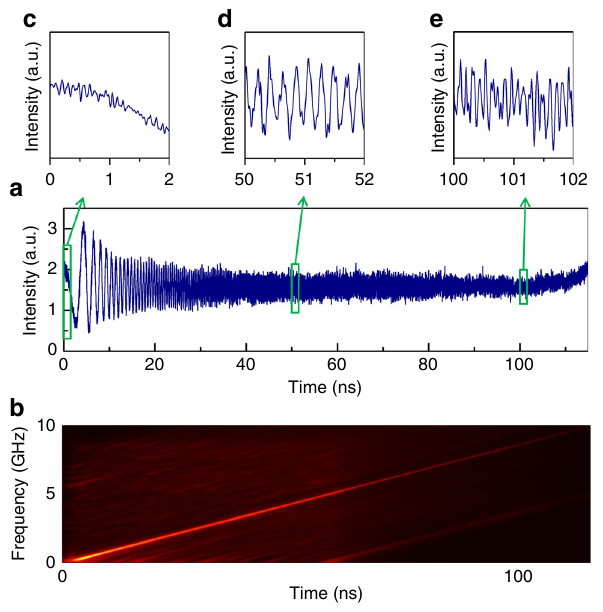
Fig. 10 Demonstration of a broadband record-long RFCW. In this experiment, f s = 8.5491 MHz. The complete RFCW is plotted in a . b corresponding Wigner – Ville distribution. The instantaneous frequencies at 0, 50, and 100 ns (temporal traces shown in the insets labeled with c , d , and e ) are, respectively, equal to DC, 4.5 GHz, and 9